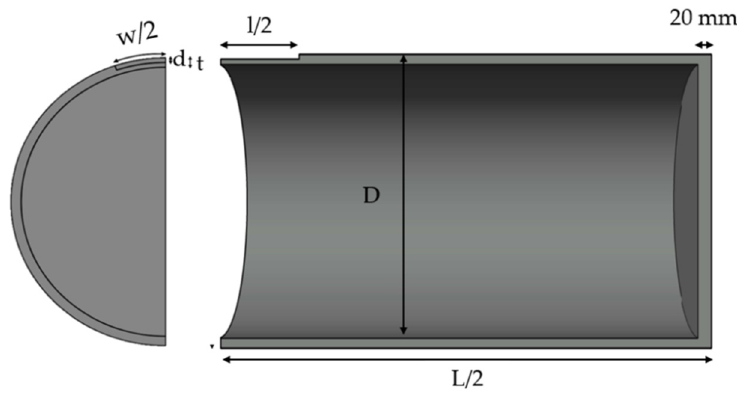
Figure 1. Dimension of the model.